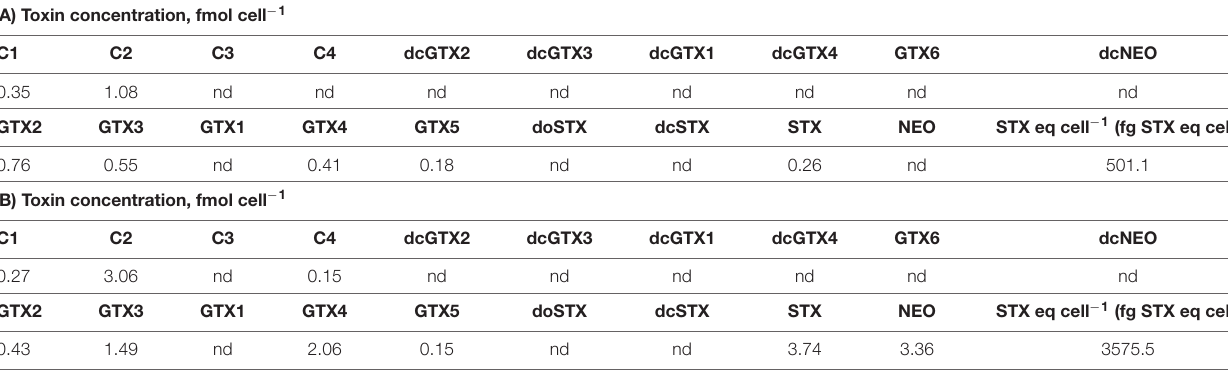
Cell toxicity of saxitoxin equivalent concentrations are calculated in (fg STX eq. cell − 1 ). (A) Toxin profile concentrations for experiment 1 and 2. (B) Toxin profile concentrations for experiment 3. Saxitoxin (STX), neosaxitoxin (NEO), Gonyautoxins 1 to 4 (GTX1, GTX2, GTX3, GTX4), N-sulfocarbamoyl (C1, C2, C3, C4) toxins, decarbamoyl (dc) toxins.